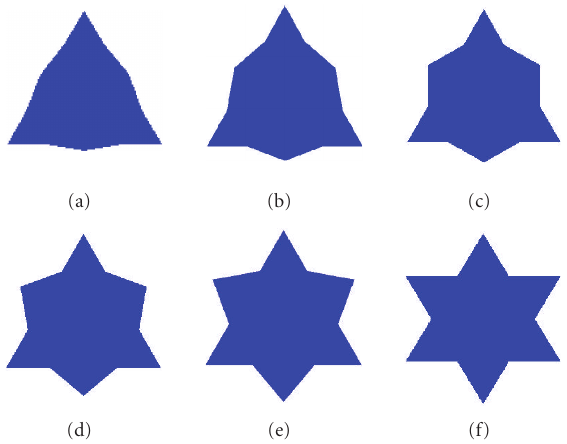
Figure 1: First iterated Koch fractal boundary microstrip antennas with indentation angles (a) 10 ◦ , (b) 20 ◦ , (c) 30 ◦ , (d) 40 ◦ , (e) 50 ◦ , and (f) 60 ◦ .